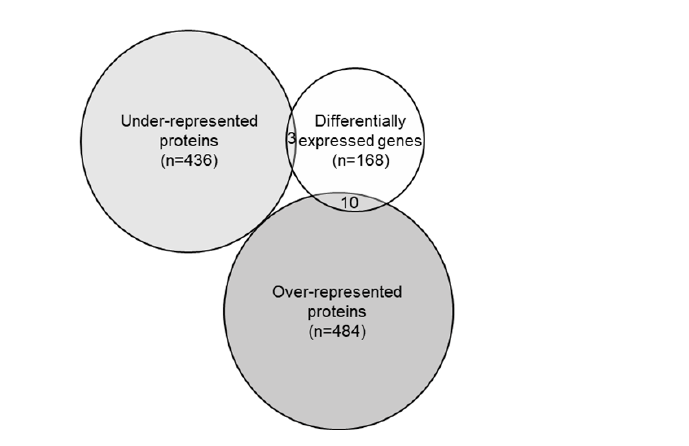
Figure 2. SF3B1 R625G impact on protein abundance. ( A ) Differential protein abundance analysis obtained using quantitative label-free LC-MS/MS analysis. The volcano plot illustrates differentially abundant proteins. The minus log p -value is plotted against the log 2 FC of protein expression ( SF3B1 R625G versus SF3B1 WT ). Proteins with at least 3 detected peptides in all replicates ( n = 3) are displayed; absolute fold change ≥ 1.2 and p -value ≤ 0.05 are considered as significantly dysregulated. External plots show proteins with peptides identified in only one condition (left in SF3B1 WT and right in SF3B1 R625G ). ( B ) Venn diagram showing a restricted overlap between the differentially abundant proteins (underrepresented and overrepresented) and the aberrantly spliced genes. A total of 8.8% aberrantly spliced genes ( n = 128/1445) display dysregulated protein levels ( n = 88 underrepresented proteins and n = 40 overrepresented proteins). ( C ) Log 2 FC of protein expression ( SF3B1 R625G versus SF3B1 WT ) is plotted on the x-axis according to the splice category: canonically spliced genes (genes with no splice aberrations), genes with predicted NMD-sensitive aberrant splice junctions, and genes with predicted NMD-insensitive aberrant splice junctions. ( D ) Overlap between differentially abundant proteins and differentially expressed genes shown by Venn diagram. A total of 7.2% of differentially abundant proteins are encoded by differentially expressed genes ( n = 13/181; n = 3 underrepresented and n = 10 overrepresented).